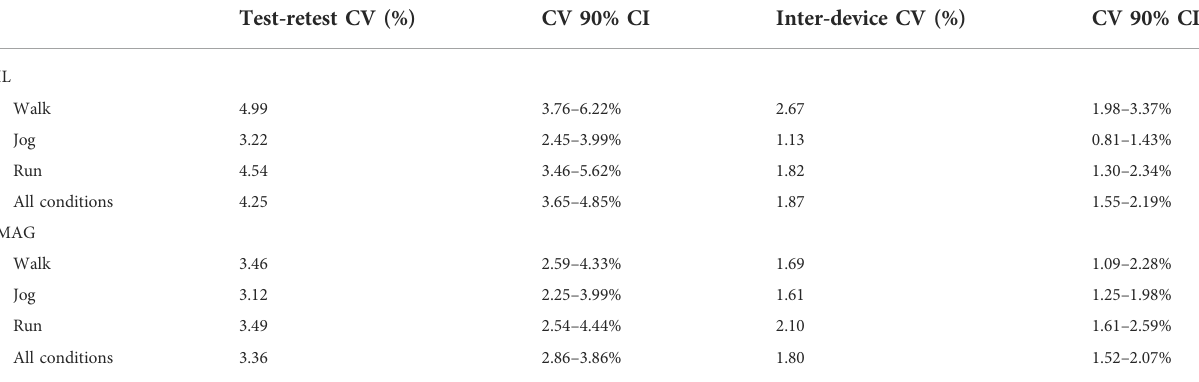
TABLE 4 The test-retest and inter-device reliability of the accelerometry derived metrics IL and